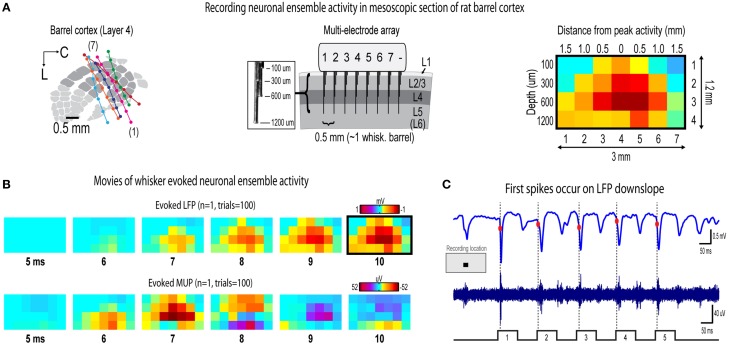
Recording movies of continuous ensemble activity in barrel cortex. (A) High fidelity 7 × 4 electrode arrays were used to acquire “snapshots” of ongoing activity across a mesoscopic section of cortex extending beyond the boundaries of rat barrel cortex and penetrating through most cortical layers (left and middle). (B) Representative movies of evoked local field potentials (LFP, top) and multi-unit potentials (MUP, bottom). The last frame of evoked LFP with dark border is same as in (A). (C) It was initially surprising to see very early, small amplitude MUP signals occurring before LFP in (B). However, when LFP (top) and MUP (bottom) filtered traces were compared during individual trials, the peak negative deflection of the first detected spike waveform occurred during LFP downslopes. The apparent discrepancy is resolved by noting the very early, small amplitude signals in trial averaged MUP (see “onset responses” in Figures 4D, 6D) that begin before the peak negative deflection of a single spike which are much more visible in individual traces.